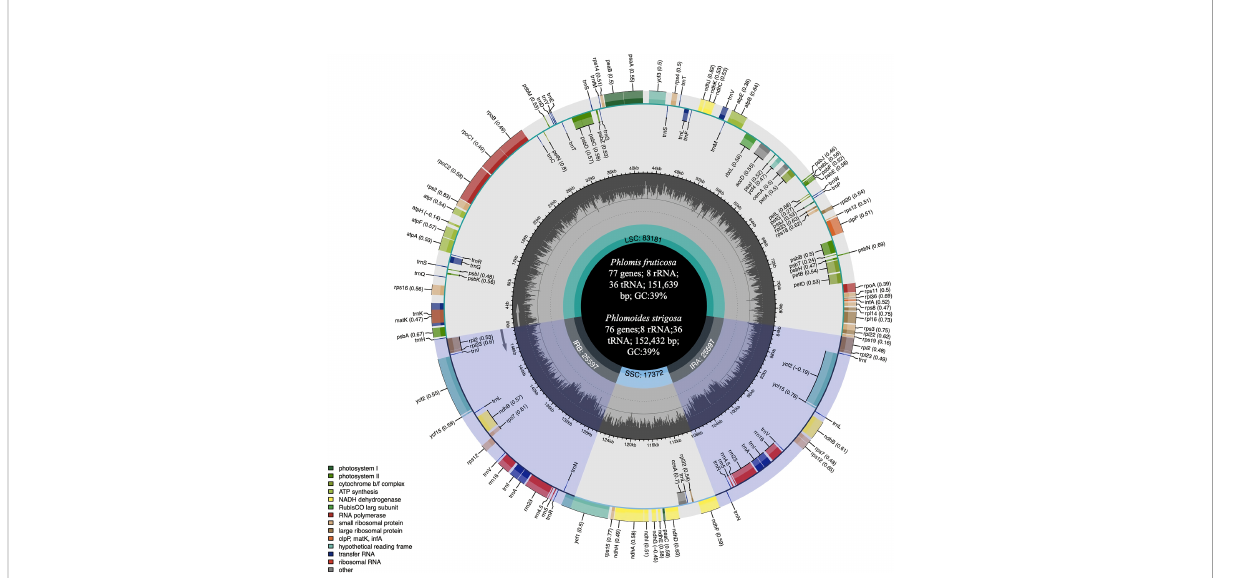
FIGURE 1 Gene map of the complete chloroplast of Phlomis fruticosa and Phlomoides strigosa . The species name and information regarding the genome are depicted in the center of the plot, including the genome length, GC contents, and annotated gene numbers. In the fi rst inner circle, the GC content is depicted as the proportion of the shaded parts of each section. The length of the corresponding single short copy (SSC), inverted repeat (IRa and IRb), and large single-copy (LSC) regions is also given. The gradient GC content of the genome is plotted in the second circle with zero level based on the outer circle. The gene names are labeled on the outer circle, with their codon usage bias in brackets. Genes are color-coded by their functional classi fi cation. Represented with arrows, the transcription directions for the inner and outer genes are listed clockwise and anticlockwise,